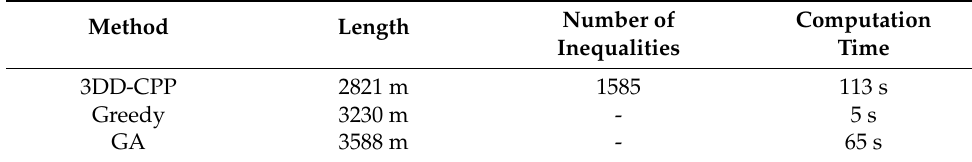
Figure 18. Path after solution. ( a ) Greedy; ( b ) GA; ( c ) 3DD-CPP. Table 4. Quantitative results in real environment